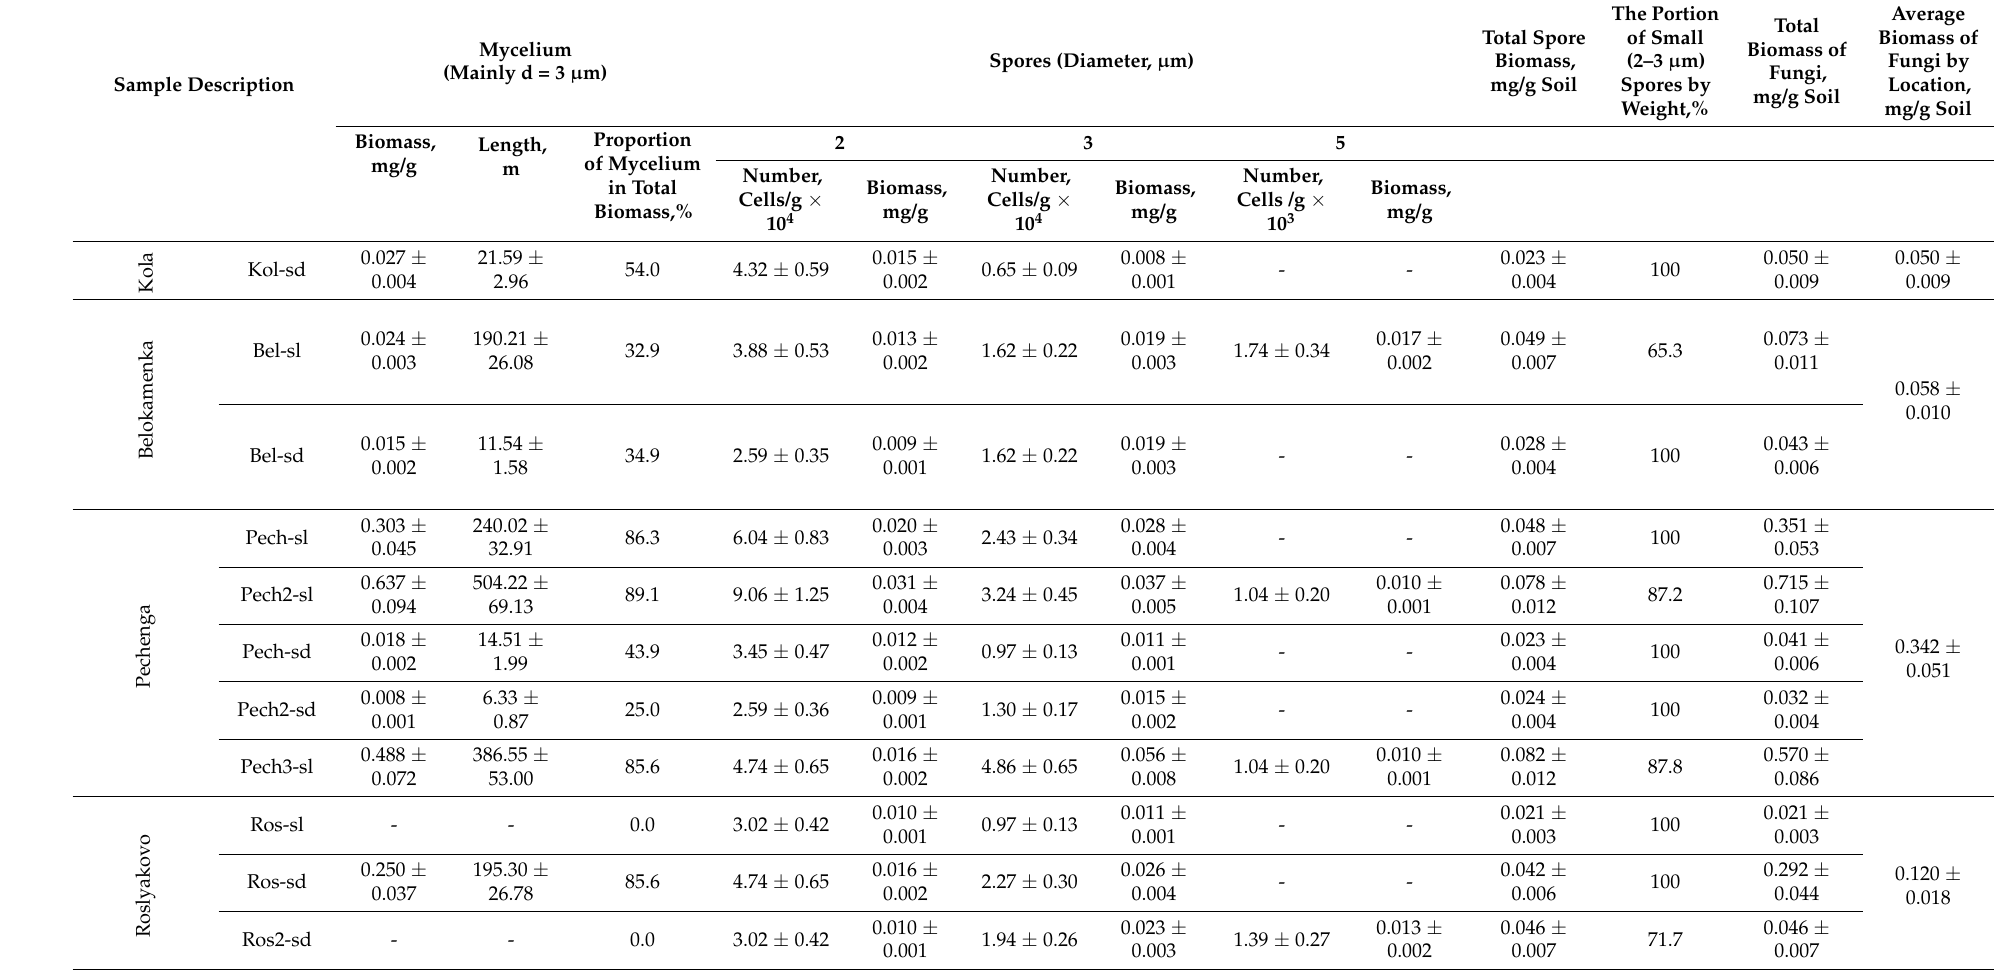
Table 2. The structure of the fungal